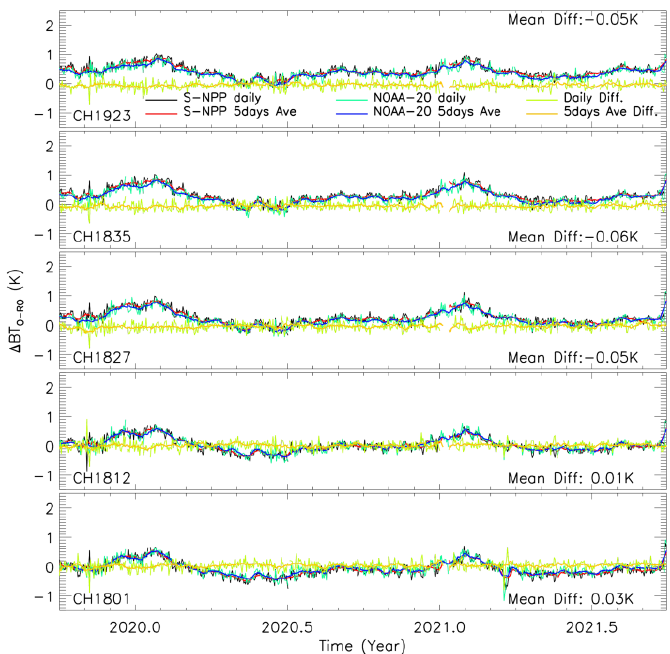
Figure 9. Same as Figure 7, except for selected CrIS channels in the SWIR band.